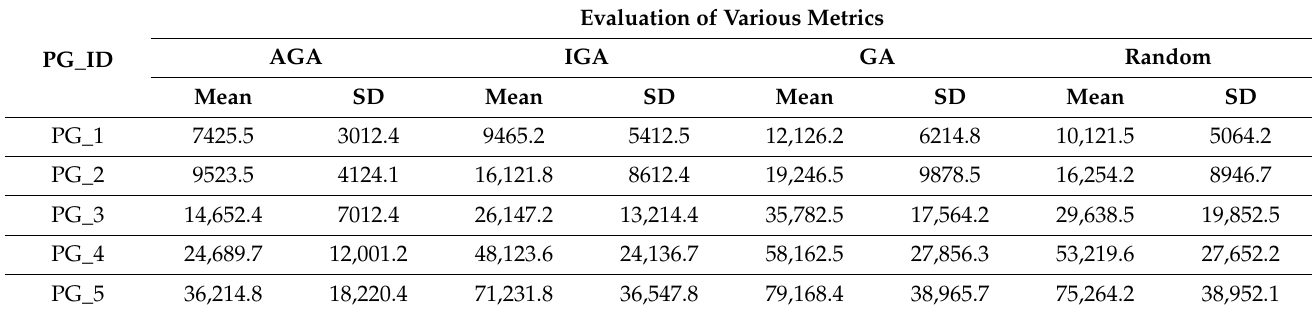
Table 6. Experimental results on the industrial